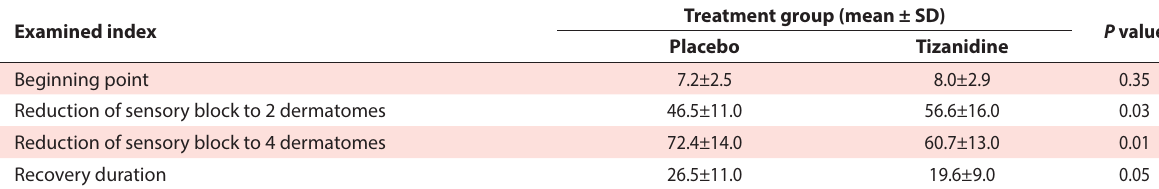
Table 2. Comparison of spinal anesthesia in various treatment groups (min)